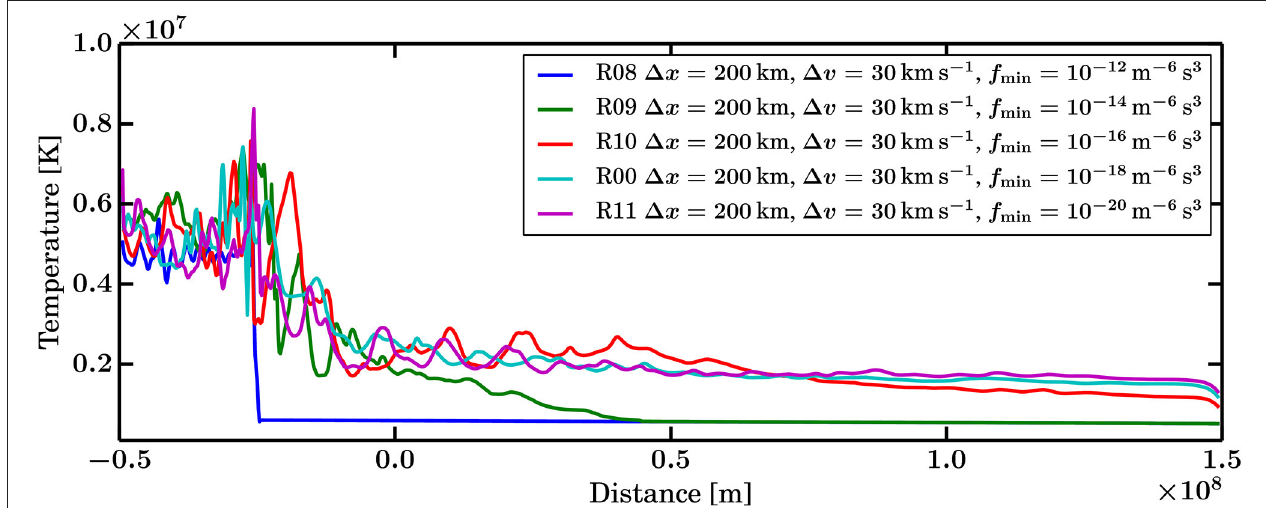
FIGURE 4 | Temperature profiles for Runs R08, R09, R10, R00, and R11 showing the effect of decreasing f min